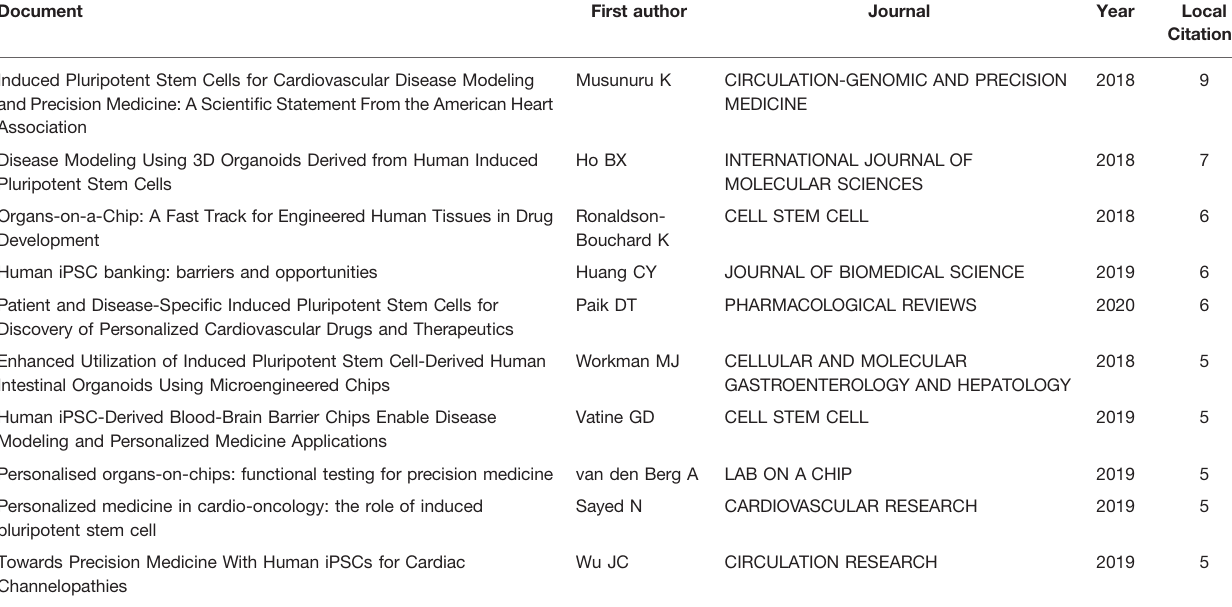
TABLE 5 | The 10 most cited documents of stem cell precision medicine in the past 5 years.